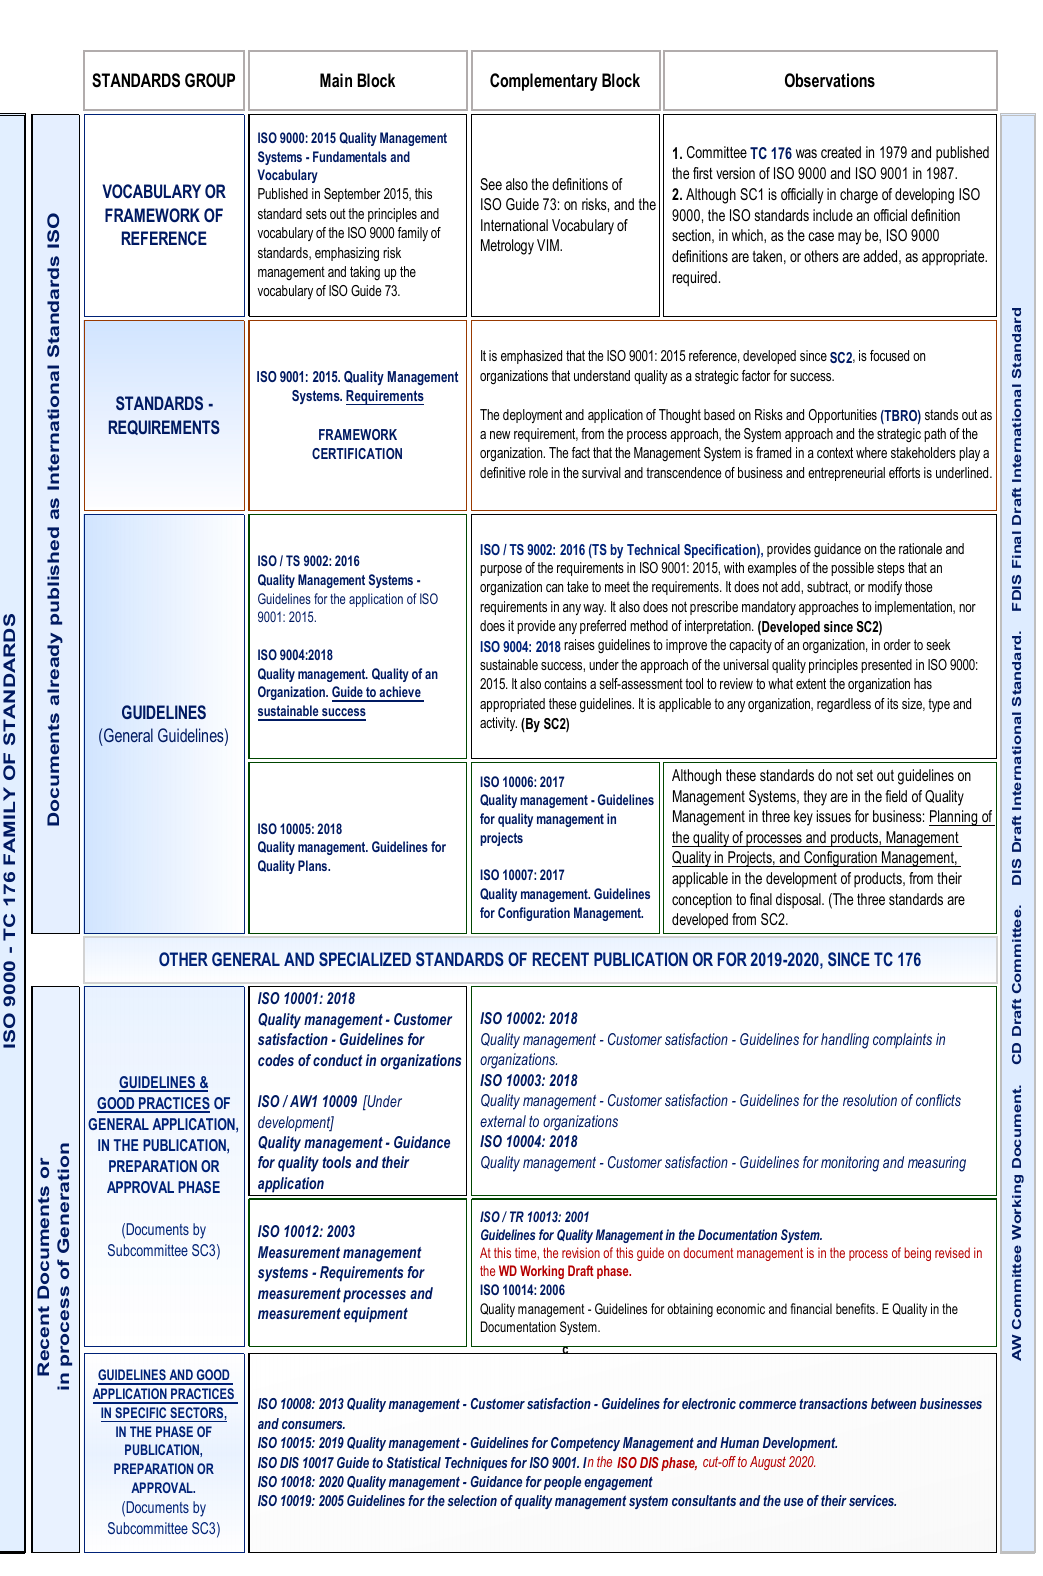
Figure A2. Approach and Logical Structure of the ISO 9000 Family of Standards [16,25].